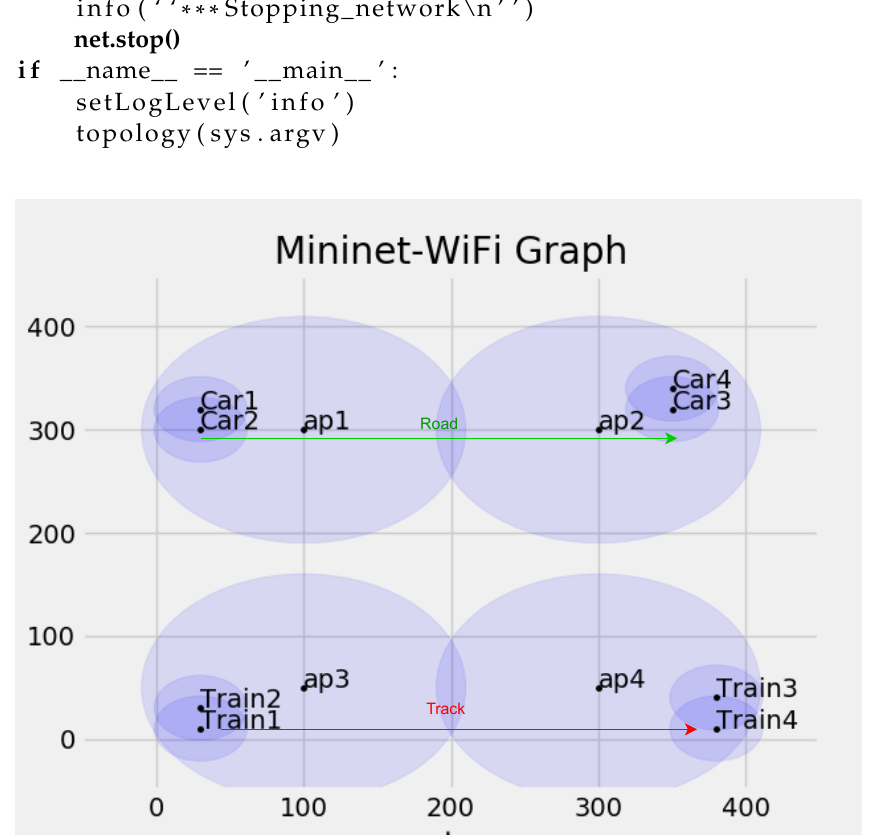
Figure 4. Hosts and access points: Mininet–WiFi graph.